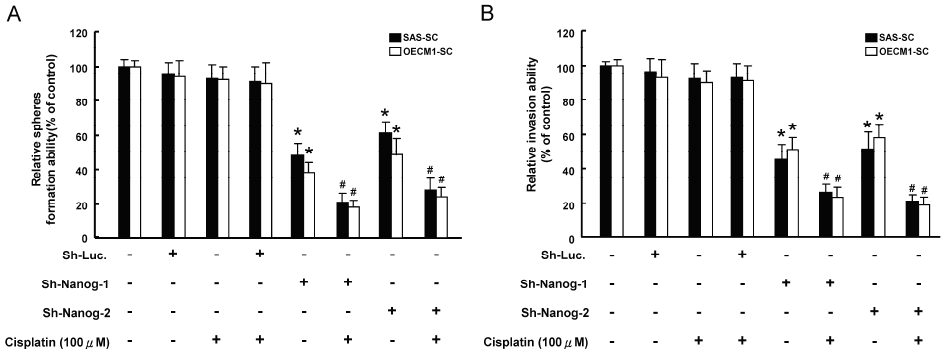
* p < 0.05 sh-Nanog-1 vs . sh-Luc; # p < 0.05 sh-Nanog-1 + Cisplatin vs. sh-Nanog-1